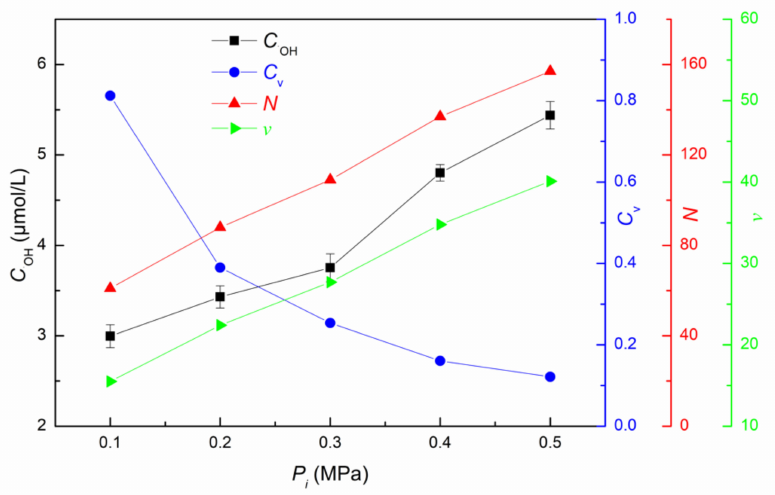
Figure 6. Influence of inlet pressure on · OH yield, C v , N , and v values. (Conditions: T = 30 ◦ C, d = 0.5 mm, t = 50 min, V = 150